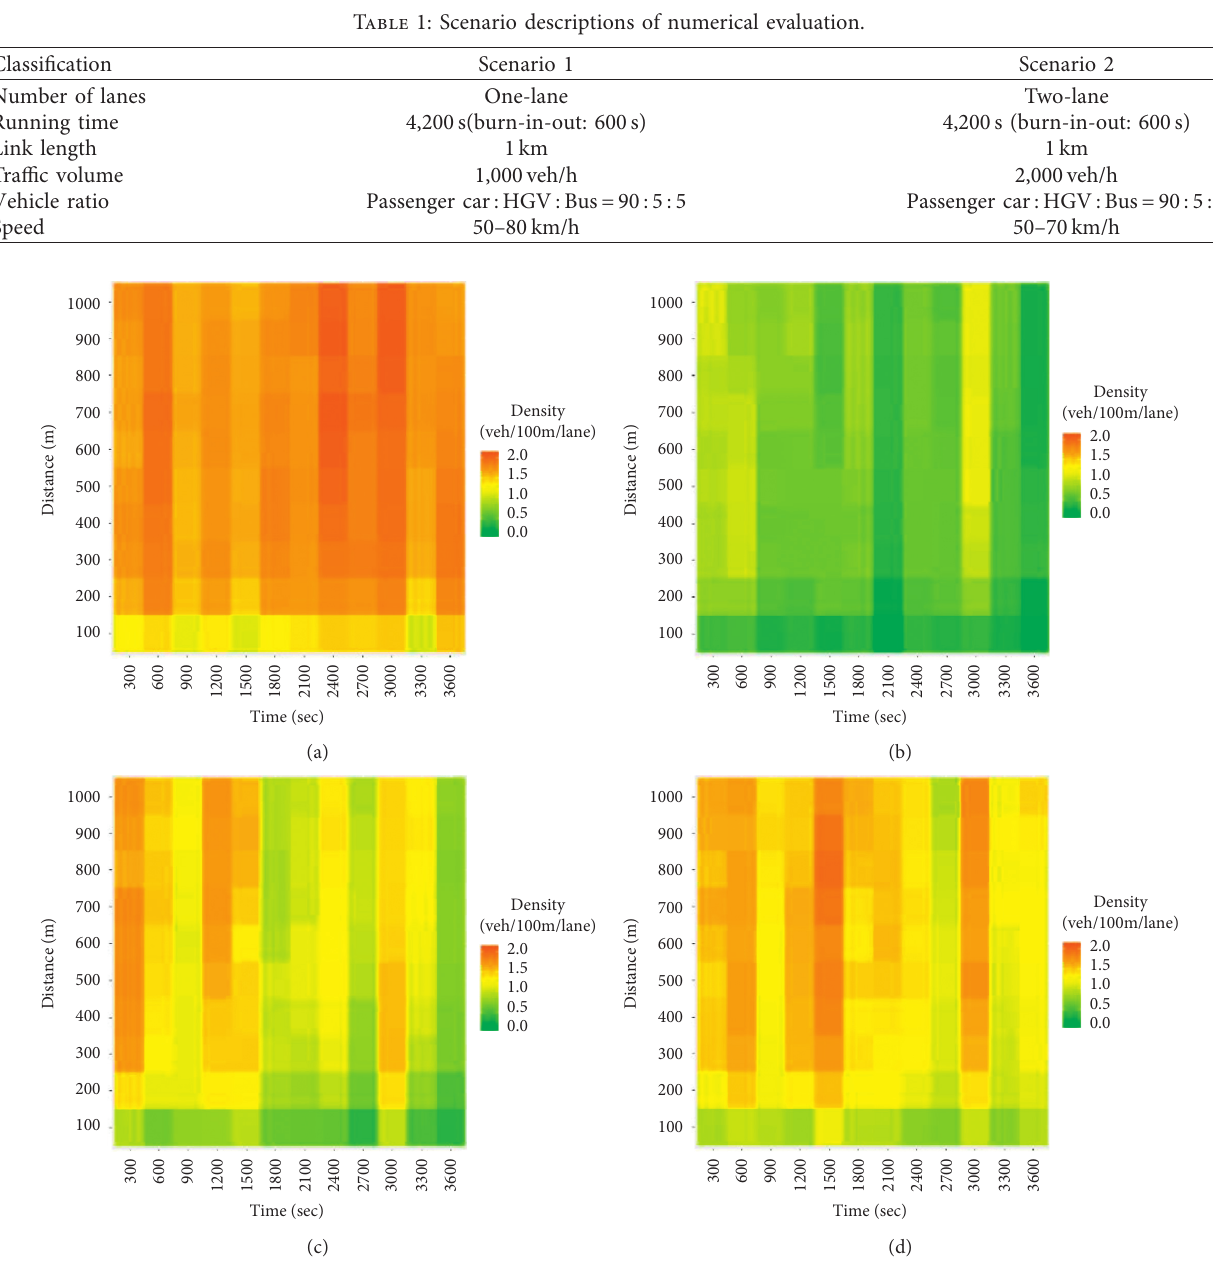
Figure 3: Estimated traffic density by sample rate of scenario 1(numerical evaluation) (a) Ground truth of traffic density (b) Estimated density at 10% sample rate (c) Estimated density at 20% sample rate (d) Estimated density at 30% sample rate. Table 2: MAPE and RMSE comparison of scenario 1 (numerical